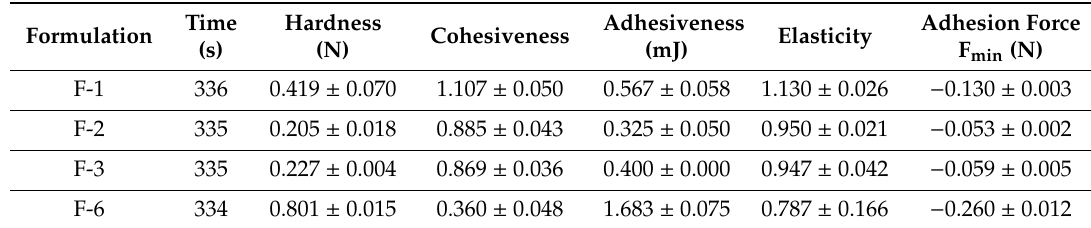
Figure 5. A curve for the texture analysis in the TPA (texture profile analysis) test (one among five for F-3 formulation—5 mg / g ACTH—Adrenocorticotropic hormone). Table 4. Texture parameters of the selected ointments calculated from the texture profile analysis ( p